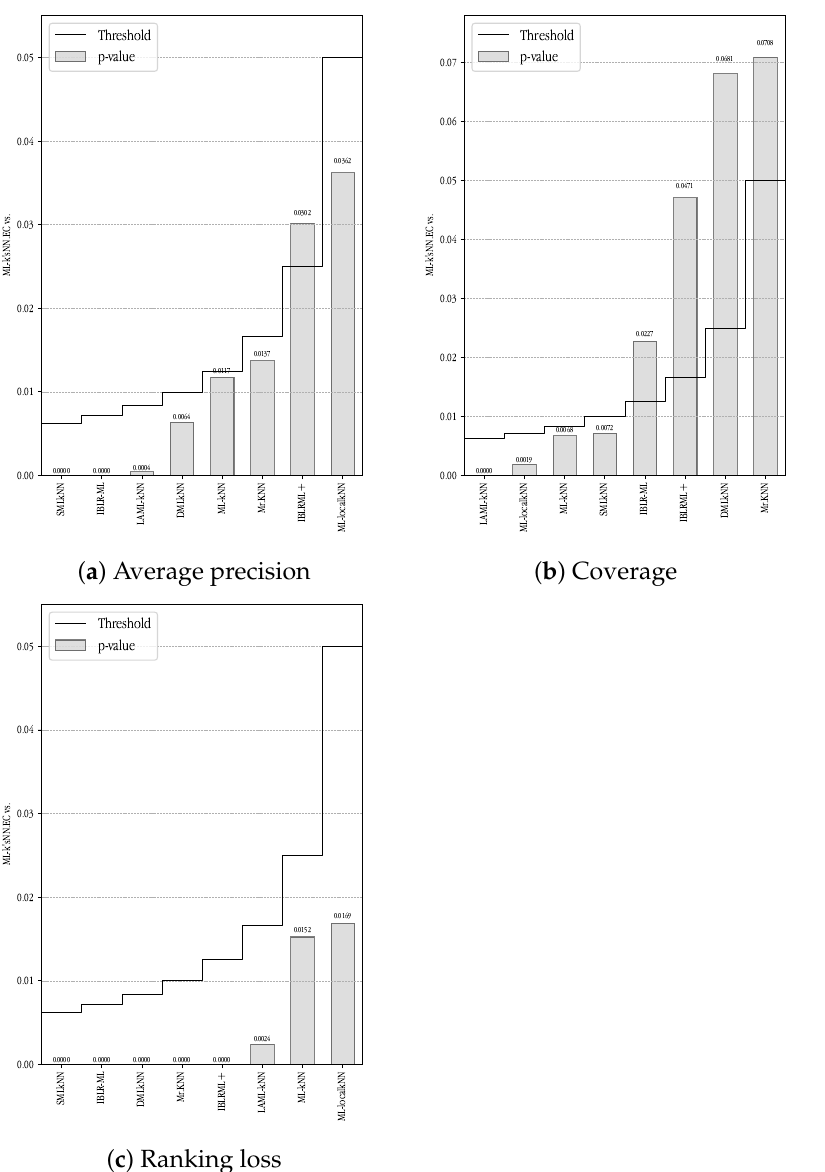
Figure 11. Holm test for the different variants of ML-kNN and the different ranking